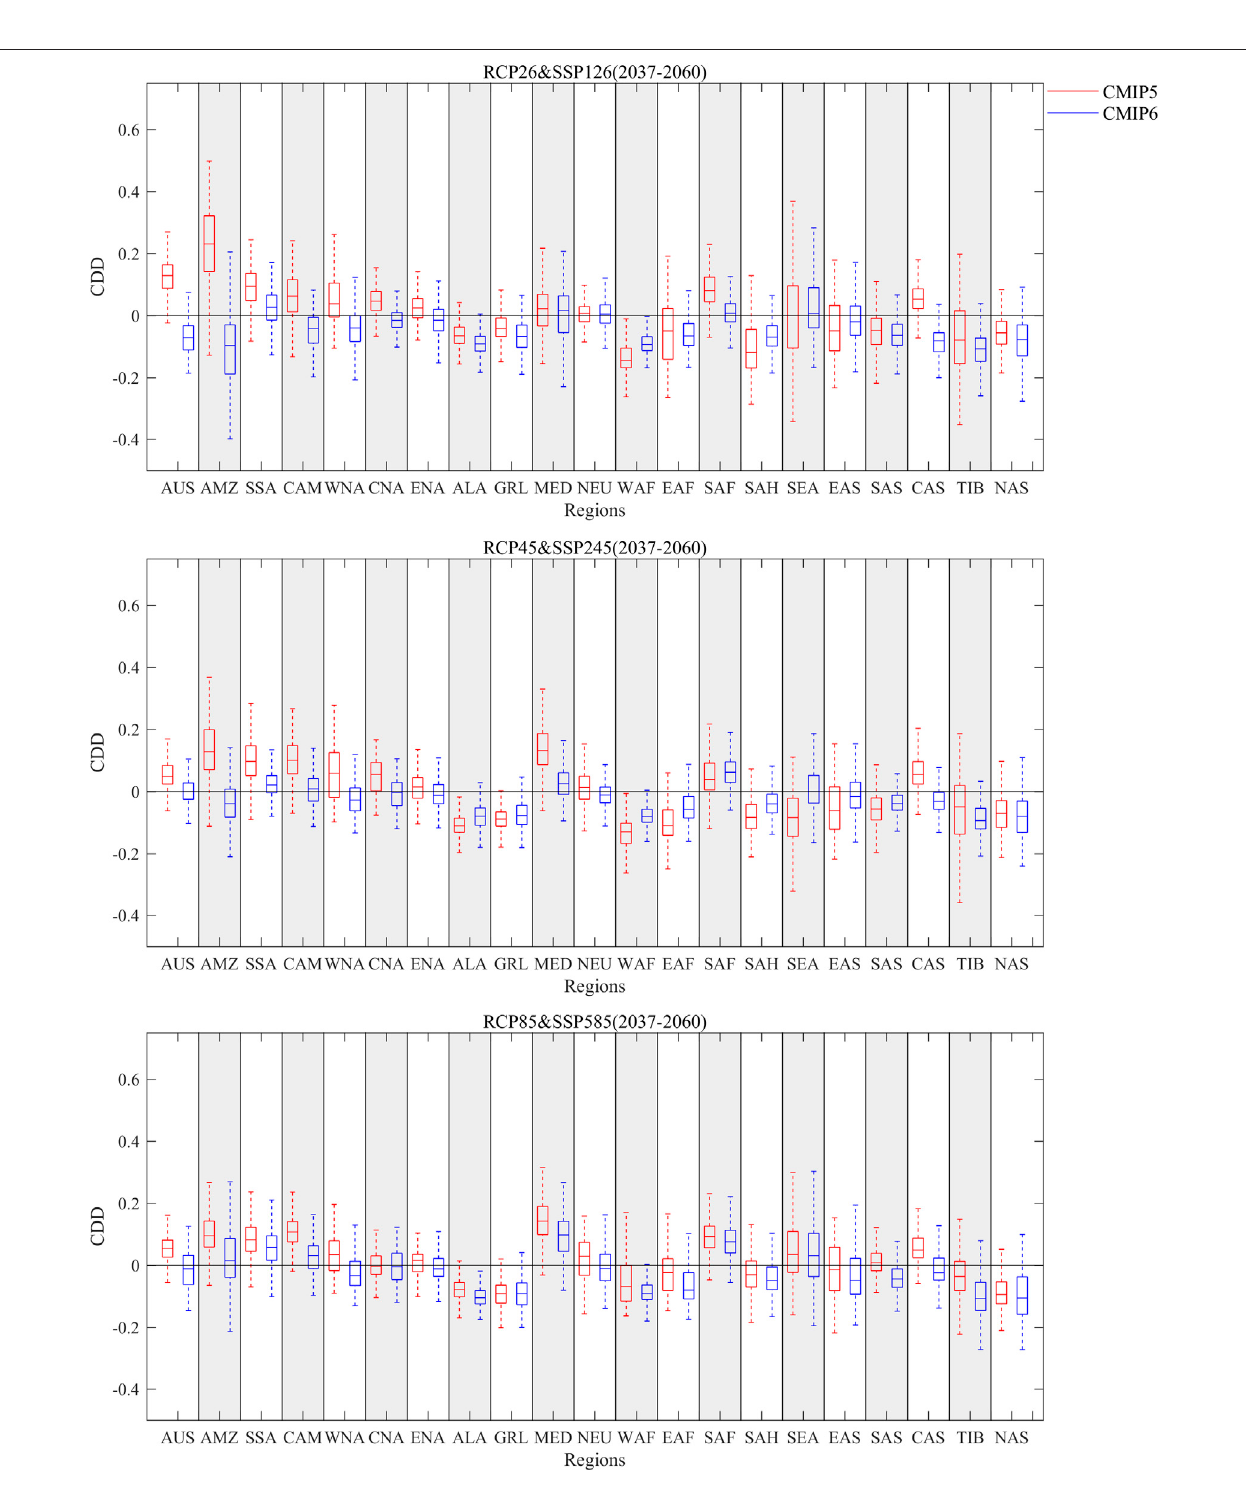
FIGURE11| Boxplots forCDD multi-model meanchanging ratesin21regionsinnear-future period (2028 – 2060) over thehistorical period (1982 – 2005) inCMIP5 and CMIP6. CMIP5 is presented in red and CMIP6 is presented in blue.